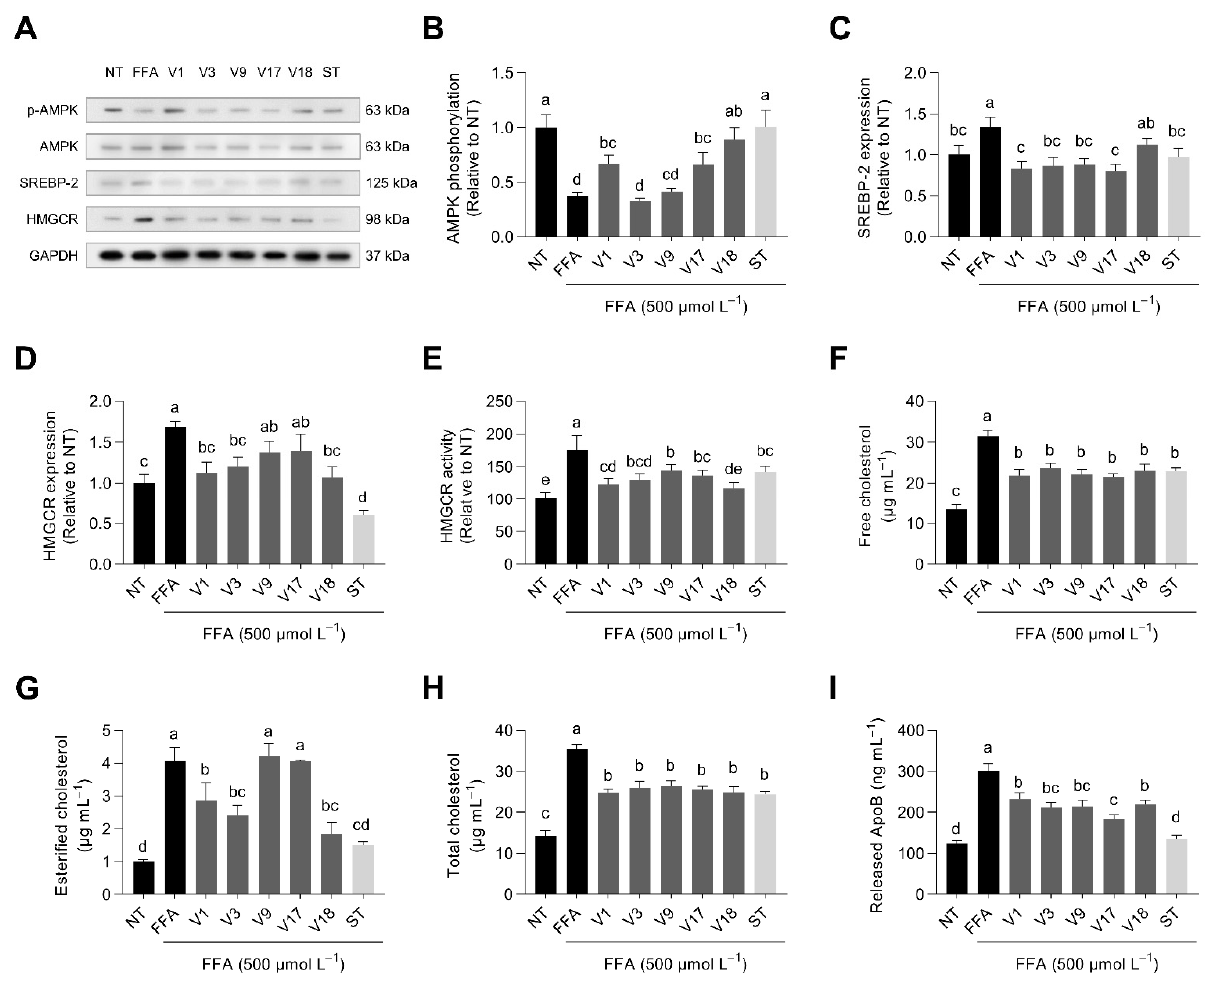
Figure 6. Effect of selected soybean digests (V1, V3, V9, V17, and V18 at 253, 160, 76, 64, and 146 µ g protein mL − 1 , respectively) and simvastatin (ST, 160 ng mL − 1 ) on the relative protein expres- sion/phosphorylation ( A ) of AMP-activated protein kinase (AMPK) as p-AMPK/AMPK ratio ( B ), sterol regulatory element-binding protein 2 (SREBP-2) ( C ), and 3-hydroxy-3-methylglutaryl-CoA reductase (HMGCR) ( D ), HMGCR relative activity ( E ), and the intracellular concentration of free ( F ), esterified ( G ), and total ( H ) cholesterol and the release of apolipoprotein B (ApoB) ( I ) in free fatty ‐ acid ‐ stimulated HepG2 liver cells (500 μ mol L − 1 oleic: palmitic acid, 2:1). Results are reported as mean ± SD ( n = 3). Bars with different letters significantly differ according to ANOVA and Tukey’s multiple range test ( p < 0.05).